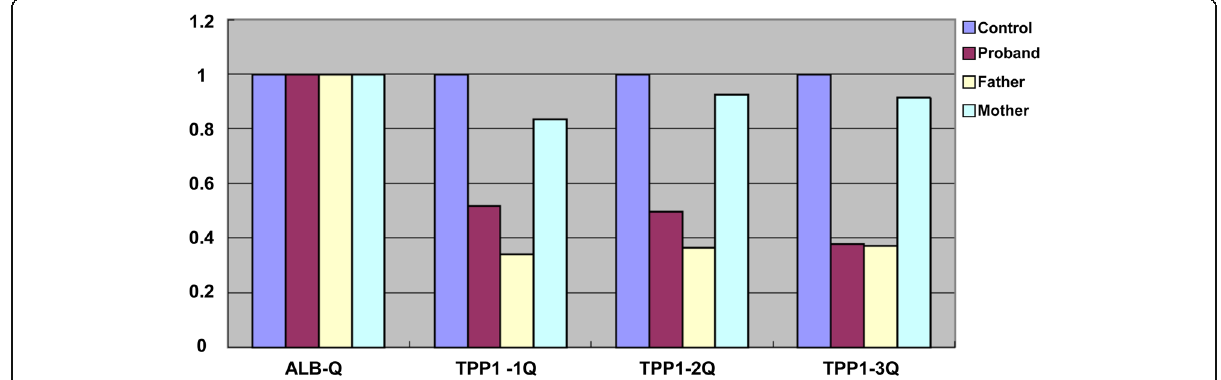
Fig. 3 Real-time quantitative PCR results of patient P6 – 1 and her parents. The qPCR results confirmed the deletion of exons 1 – 3 in TPP1 gene in patient P6 – 1 and her father as compared to a normal